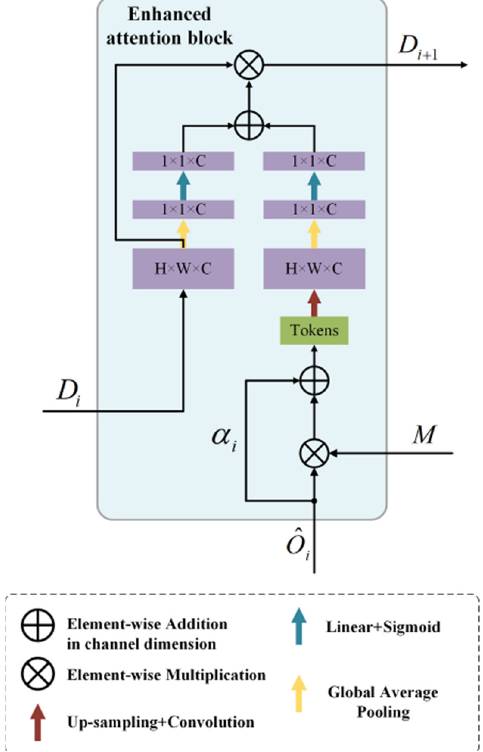
Figure 4. The illustration of enhanced attention block. Different from traditional CAA module that it receives multiple features for aggregating attention information and refining boundaries, which is to utilize a feature fusion between global and local contexts along channel-wise for achieving better performance of attention learning.